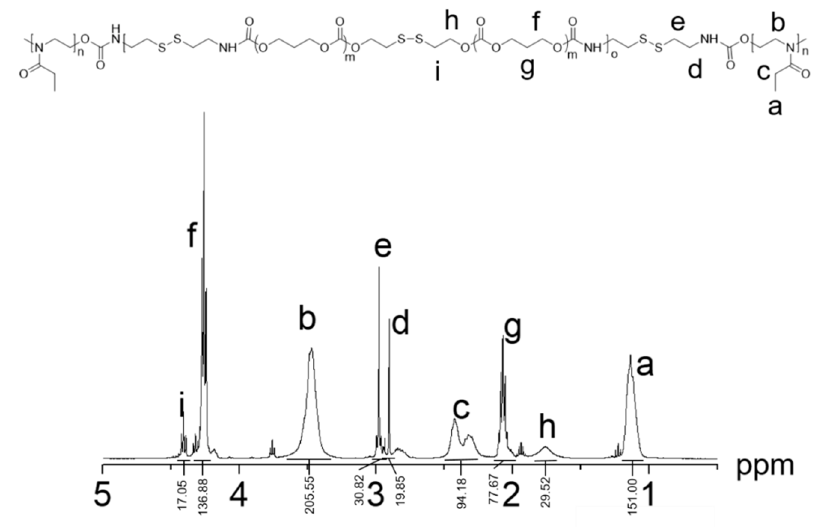
Figure 1. 1 H NMR spectra (400 MHz, C D Cl 3 ) of PEtOz-PU(PTMCSS)-PEtOz.